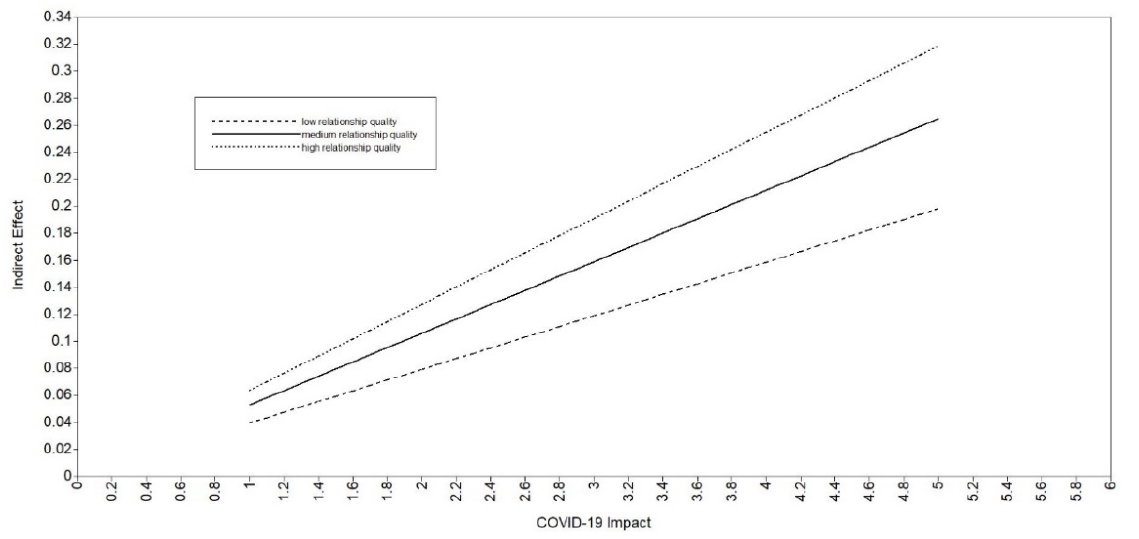
Figure 3. Plot of the Indirect Effect of COVID-19 Impact on Depressive Symptoms Through Financial Distress at Different Levels of Romantic Relationship Quality (Model 3). Note: low = one standard deviation below the mean, medium = the mean, high = the highest value.